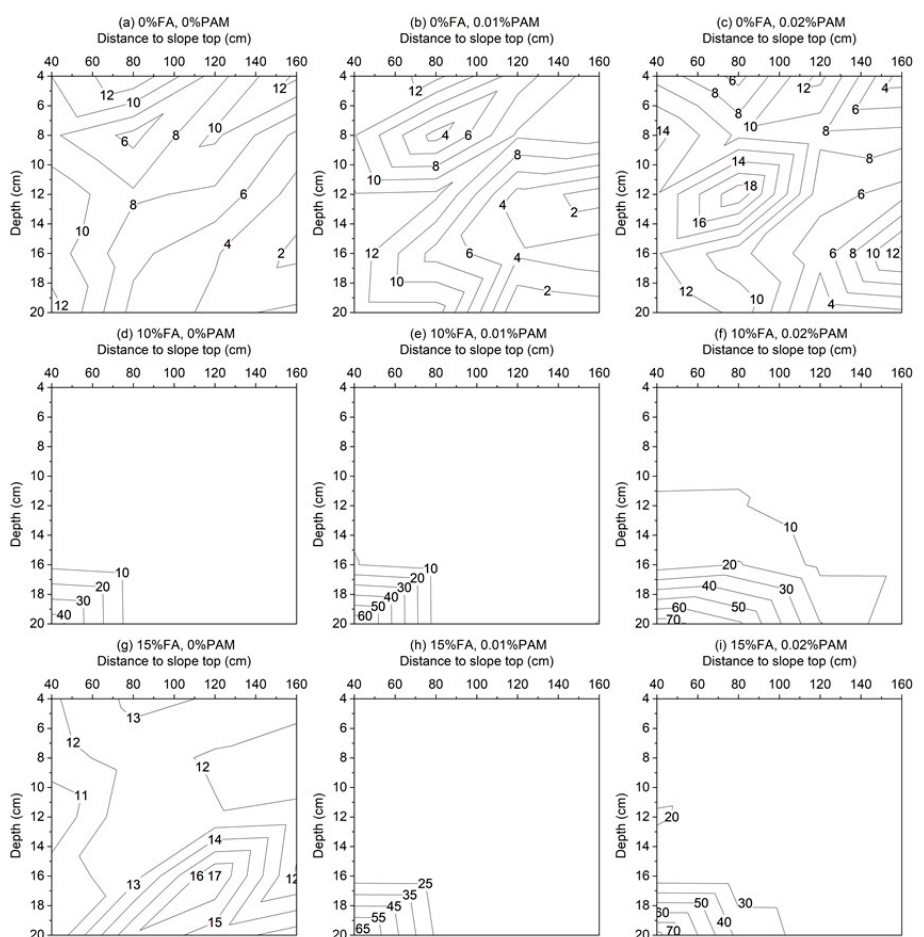
Figure 9. Contour plot displaying redistribution of NO 3 − -N (Unit: mg/kg) in soil profiles amended with different CFA and PAM dosages (i.e., 0% CFA + 0% PAM ( a ), 0% CFA + 0.01% PAM ( b ), 0% CFA + 0.02% PAM ( c ), 10% CFA + 0% PAM ( d ), 10% CFA + 0.01% PAM ( e ), 10% CFA + 0.02% PAM ( f ), 15% CFA + 0% PAM ( g ), 15% CFA + 0.01% PAM ( h ), 15% CFA + 0.02% PAM ( i )) after rainfall.